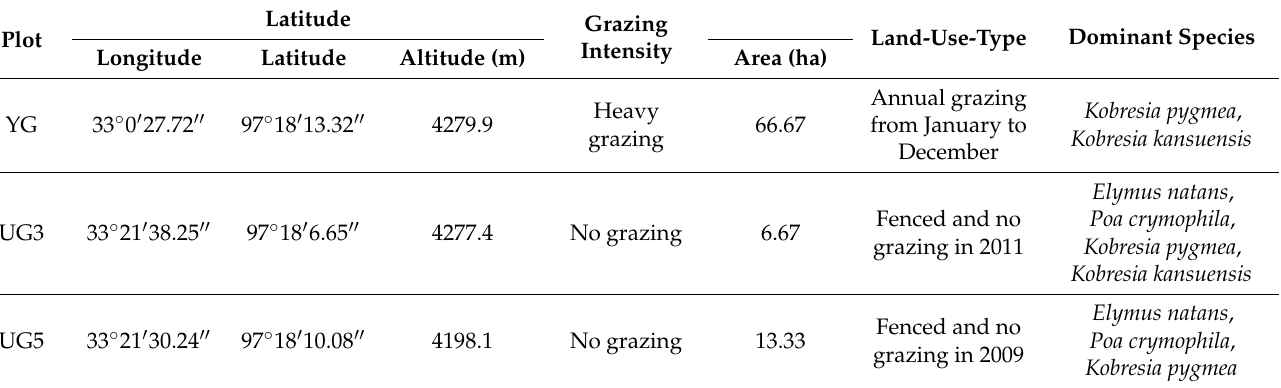
Table 3. The basic characteristics of the test